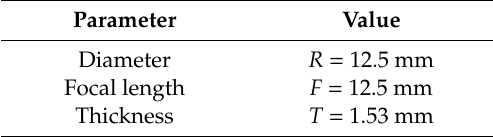
Table 3. Designed parameters of a 3D-printed lens.